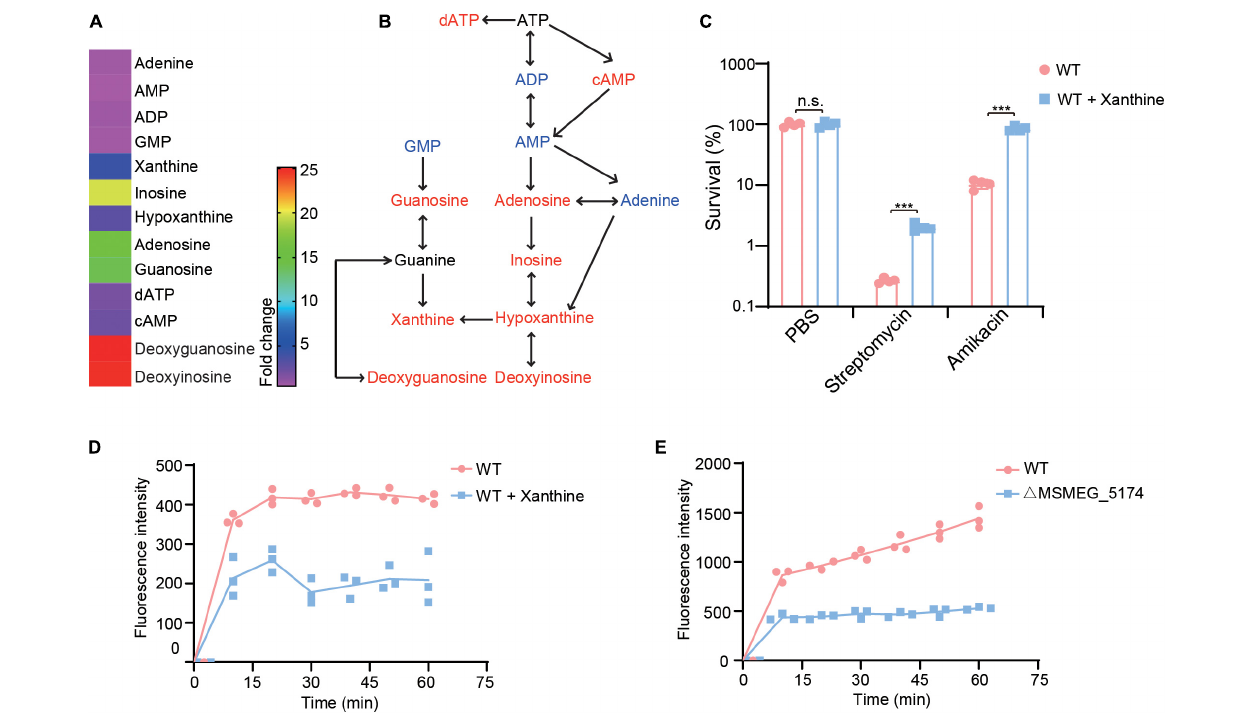
FIGURE 5 | Xanthine decreases aminoglycoside antibiotics lethality for M. smegmatis . (A) Fold changes of purine metabolites in MSMEG_5174 mutants compared to WT. (B) Purine metabolic pathway. Red and blue color represent upregulated and downregulated metabolites in MSMEG_5174 mutants, respectively. (C) Percent survival of M. smegmatis in the presence or absence of xanthine with indicated antibiotics treatment. (D) EB accumulation in WT cultured with or without xanthine. (E) EB accumulation in WT and MSMEG_5174 mutants. ** P < 0.01.